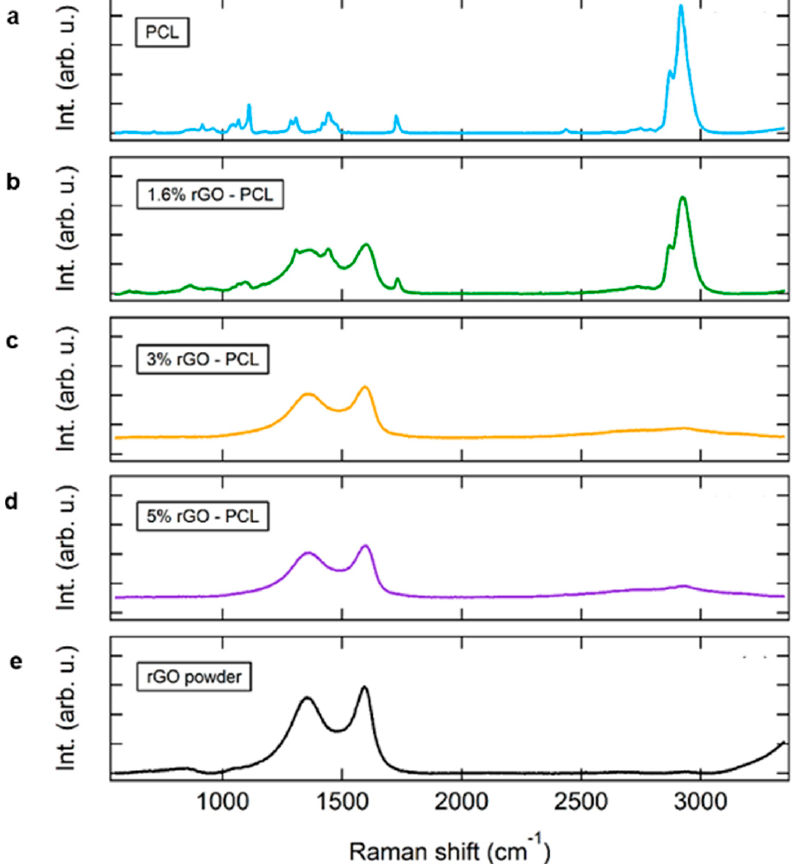
Figure 1. Raman spectra: PCL ( a ), 1.6% rGO-PCL ( b ), 3% rGO-PCL ( c ), 5% rGO-PCL ( d ), and rGO powder ( e ).